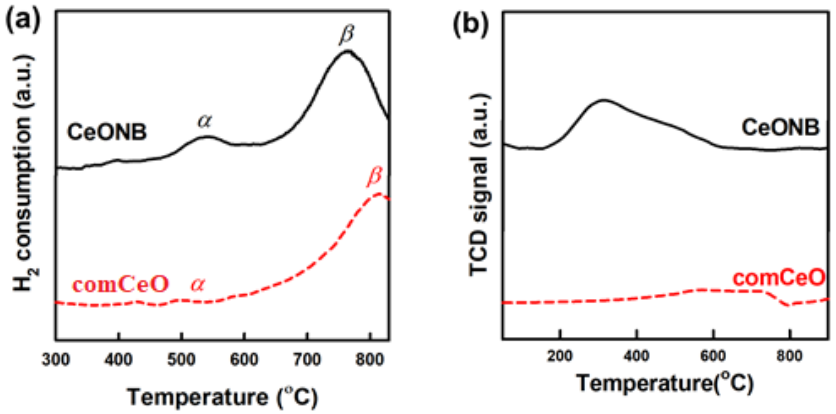
Figure 6. ( a ) TPR profiles, and ( b ) TPD-O 2 profiles of CeONB and comCeO.